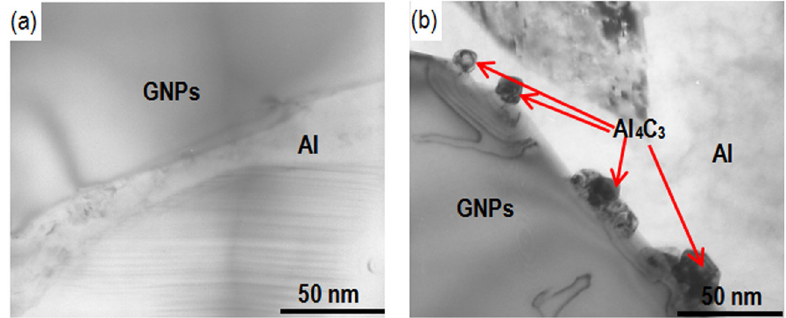
Figure 4: TEM images of interface in GNP/Al composites: ( a ) 0.3 vol% of GNP/Al and ( b ) 1.2 vol% of GNP/Al. Reproduced from ref. [ 54 ]